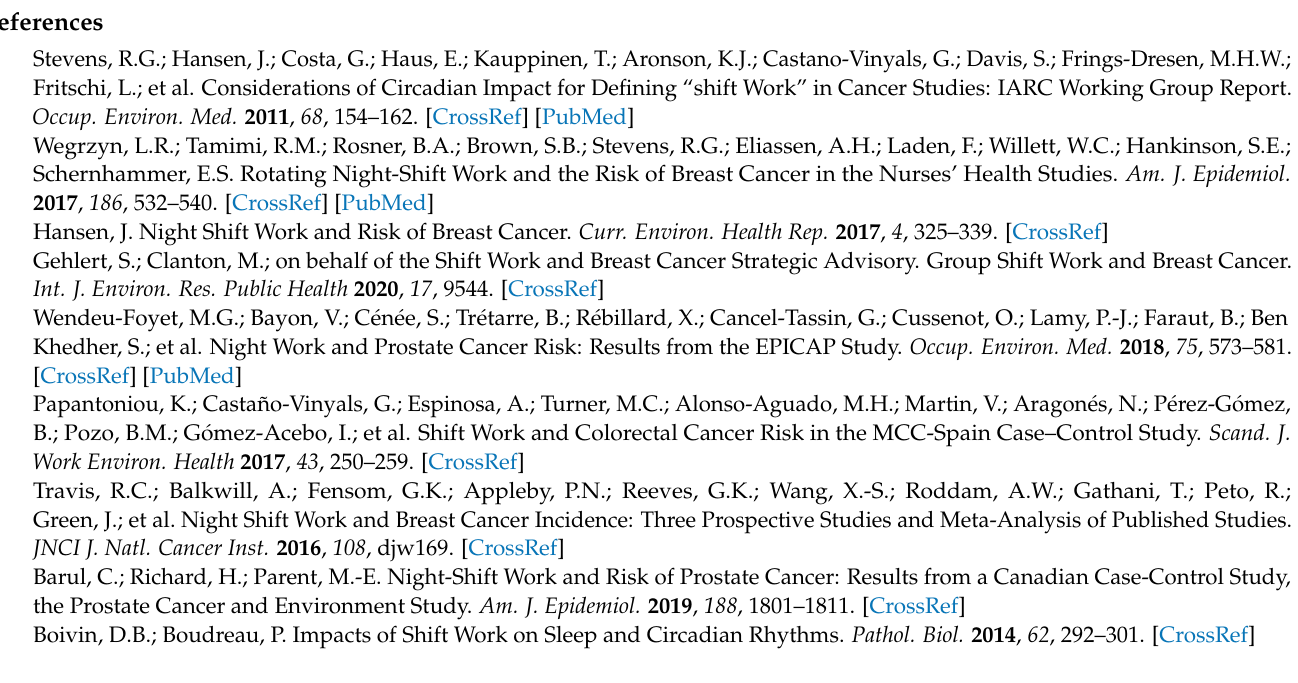
Figure S2, RT-qPCR of the period gene; Table S1: Activity data for Figure 1, Table S2: Activity data for Figure S1; Table S3, RT-qPCR enrichment data; Table S4, Tabulation of repair type percentage by